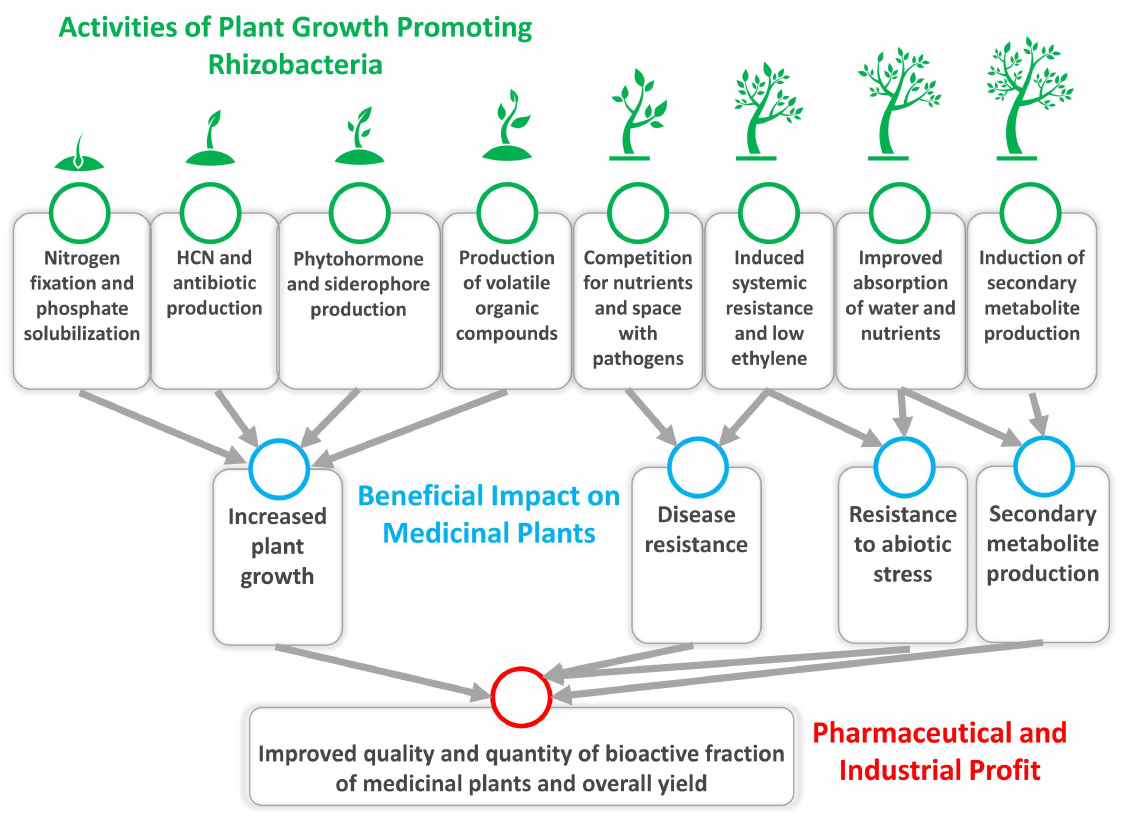
Figure 1. A schematic representation of direct (N 2 fixation; P solubilisation; phytohormone secretion) and indirect (cyanogenesis, growth modulating enzymes, siderophores and induced systemic resis- tance, ISR, etc.) mechanisms adopted by plant growth promoting rhizobacteria for optimizing the growth, yield and quality of bio-antimicrobials of medicinal plants while growing under conventional or stressed environments at bench scale or under real field